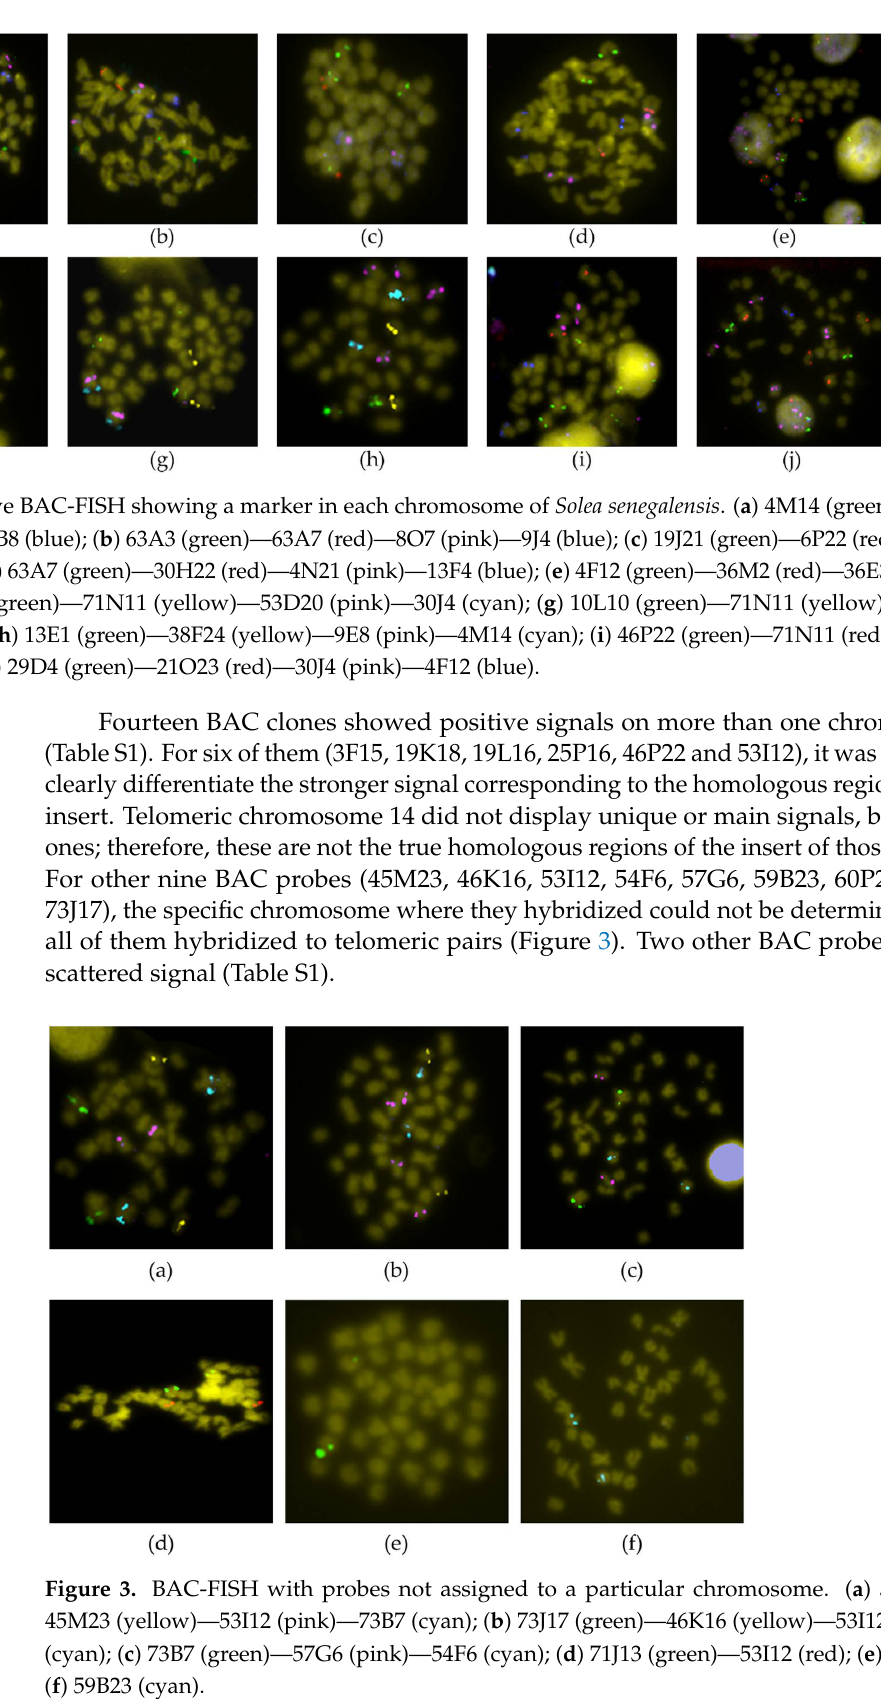
Figure 1. Idiogram of Solea senegalensis showing positive signals of 83 BAC probes. Seventy-eight of them were assigned to specific chromosomes (green lines) and five showed multiple signals that cannot be assigned to a specific chromosome (red lines). Orange lines represent the secondary signals of the specifically located BAC probes.